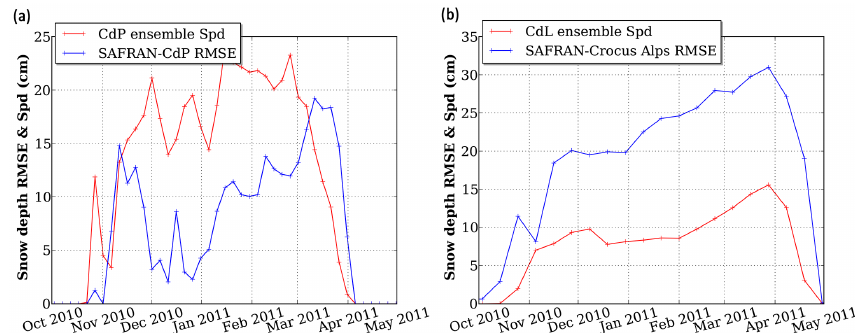
Figure 2. Time evolution over the 2010/2011 season of (in red) the SD ensemble Spd with respect to the ensemble mean and (in blue) the SD RMSE between SAFRAN-Crocus estimates and in situ observations, (a) for the CdP site and (b) for the CdL ensemble compared to the multiple Alps stations at the same elevation as